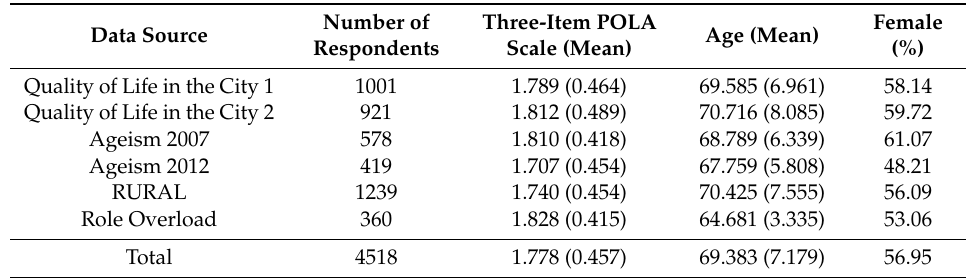
Table 1. The basic characteristics of the data